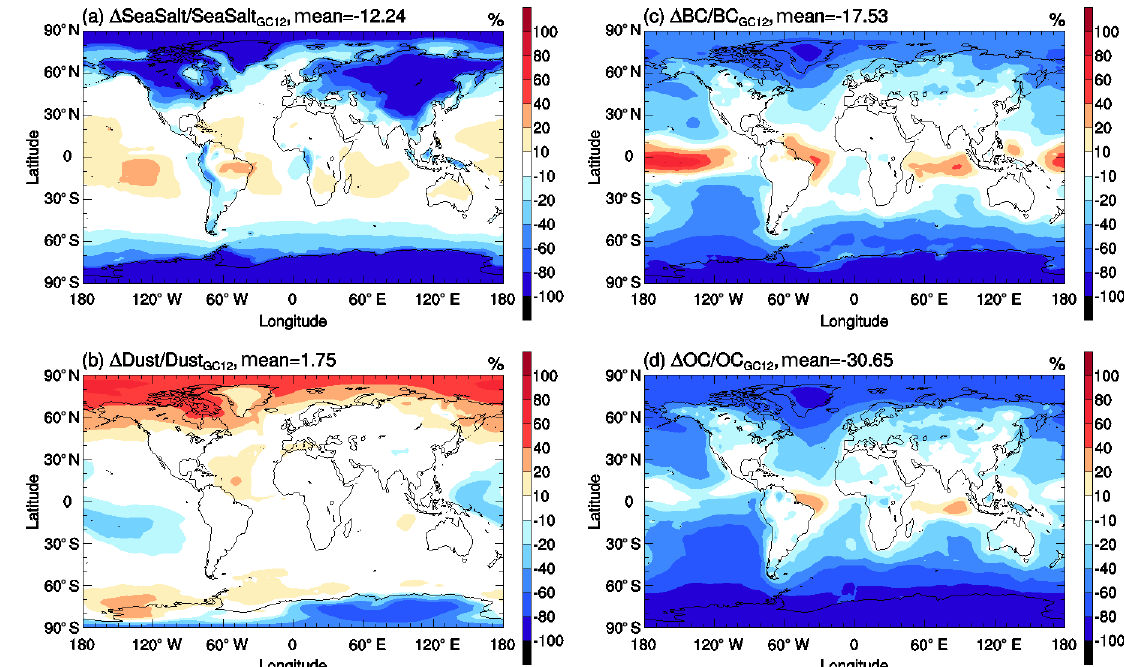
Figure 14. The same as Fig. 13 but for (a) sea salt, (b) dust, (c) black carbon, and (d) organic carbon surface mass